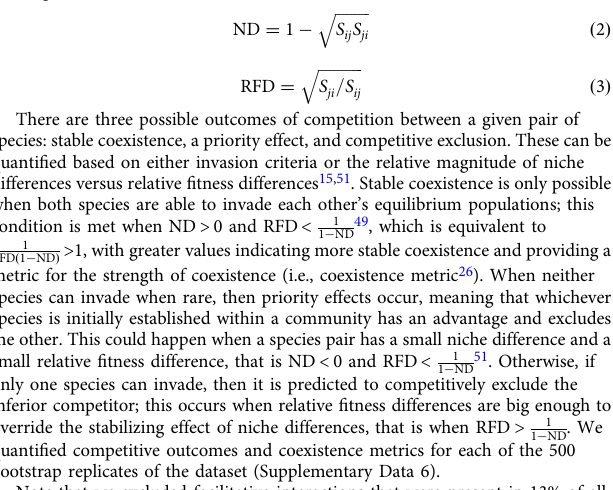
Figshare 53 , at https://doi.org/10.6084/m9. fi gshare.19108127.v1. Source data are provided with this